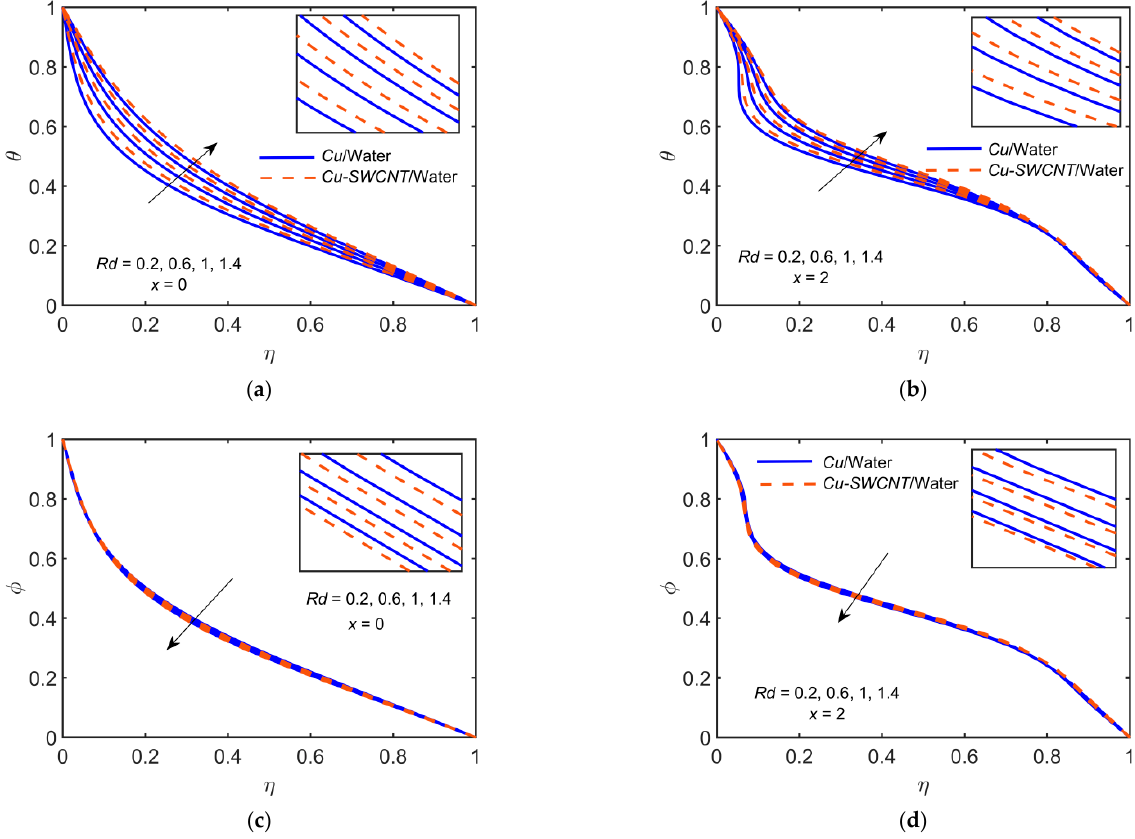
Figure 9. ( a ) 𝜃 profile at 𝑥 = 0 , ( b ) 𝜃 profile at 𝑥 = 2 , ( c ) 𝜑 profile at 𝑥 = 0 , and ( d ) 𝜑 profile at 𝑥 = 2 for distinct val- Figure 9. ( a ) θ profile at x = 0, ( b ) θ profile at x = 2, ( c ) ϕ profile at x = 0, and ( d ) ϕ profile at x = 2 for distinct values of Rd ues of 𝑅𝑑 .